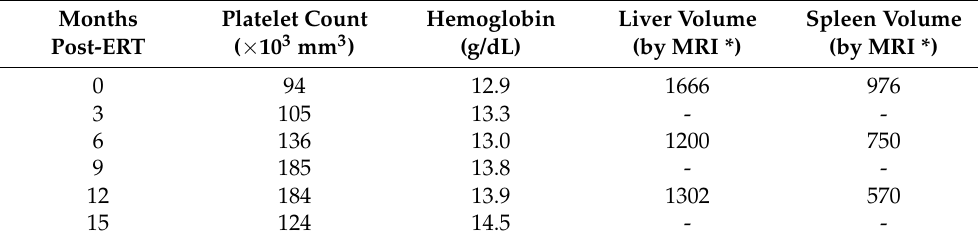
Table 4. Clinical data for 55-year-old female GD type 1 patient